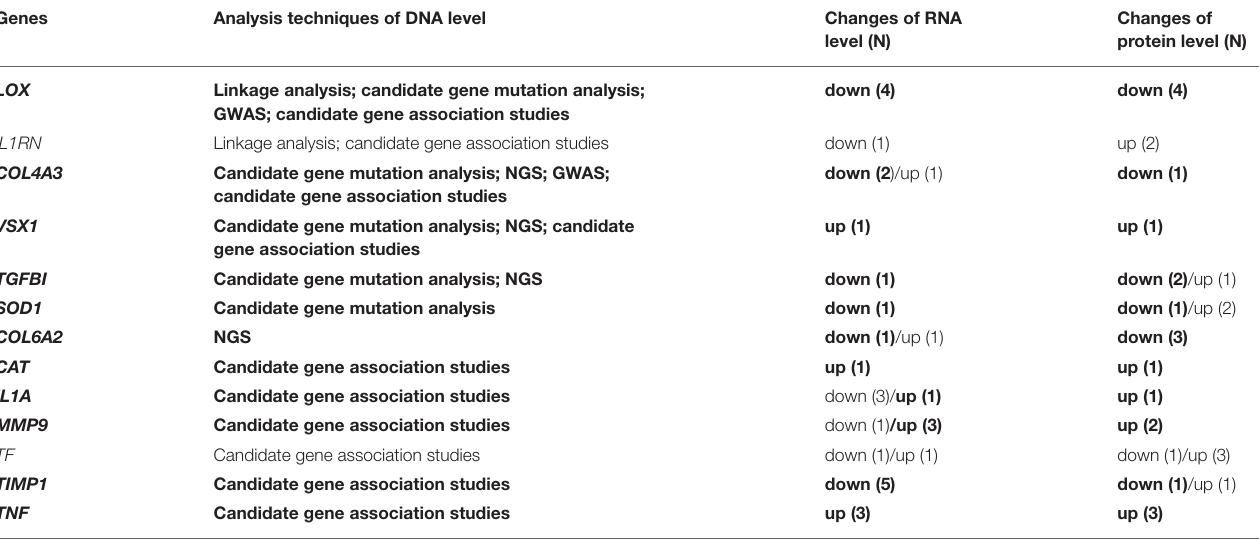
TABLE 1 | Overlapping genes between multi-levels.